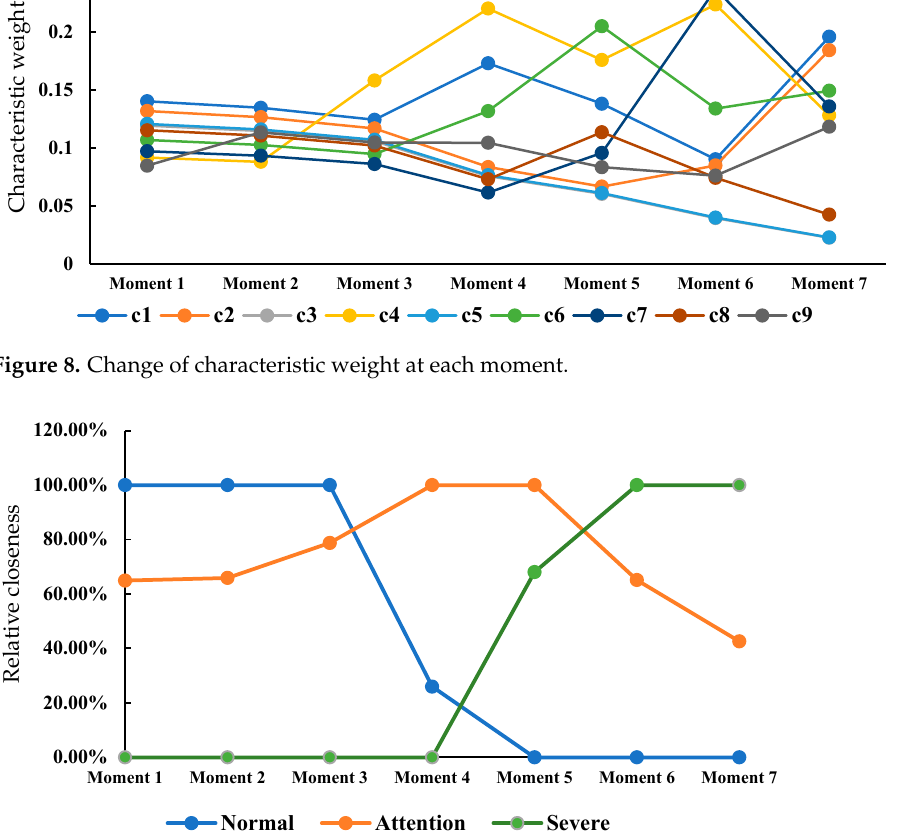
Figure 9. Variation of the closeness of the protection system to each state level at each moment.